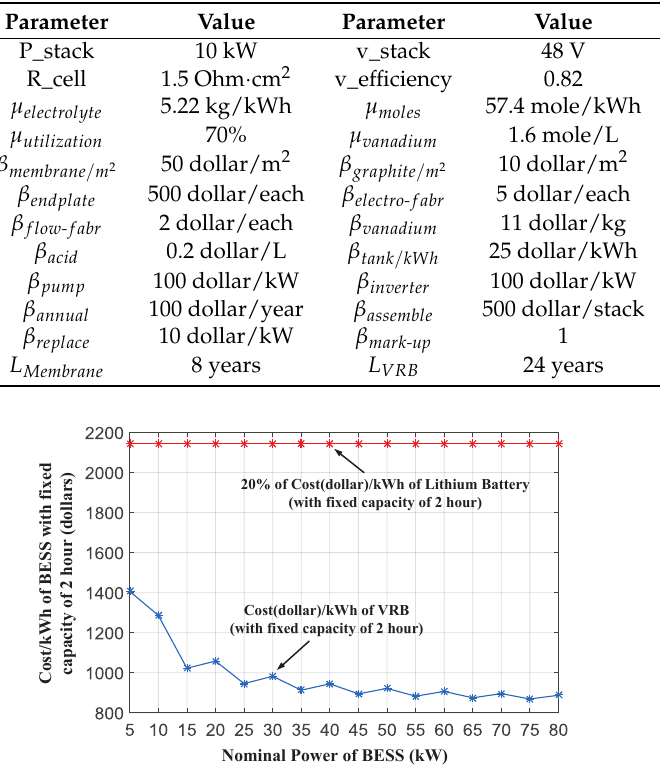
Table 2. Key parameters for VRB cost computation.